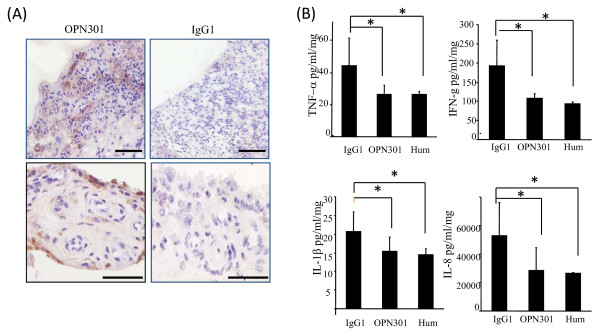
OPN301 inhibition of spontaneous cytokine release is comparable to that observed for Adalimumab. (A) One representative image of OPN301 penetration of RA synovial explant cultures of four RA patients. OPN301 was localized to the perivascular and lining layer regions with no staining observed for IgG control. The bar on the lower right hand corner of each photomicrograph represents a distance of 100 μm on the top panel and 50 μm on the bottom panel. (B) OPN301 (1 μg/ml) inhibited spontaneous cytokine release from RA synovial explant cultures (n = 13) and effect that was comparable to that observed anti-TNFα mAb Adalimumab (Hum, 1 μg/ml). Results are expressed as mean ± SEM. * P < 0.05 and ** P < 0.001 significantly different from control as determined using Wilcoxon Signed Rank analysis.